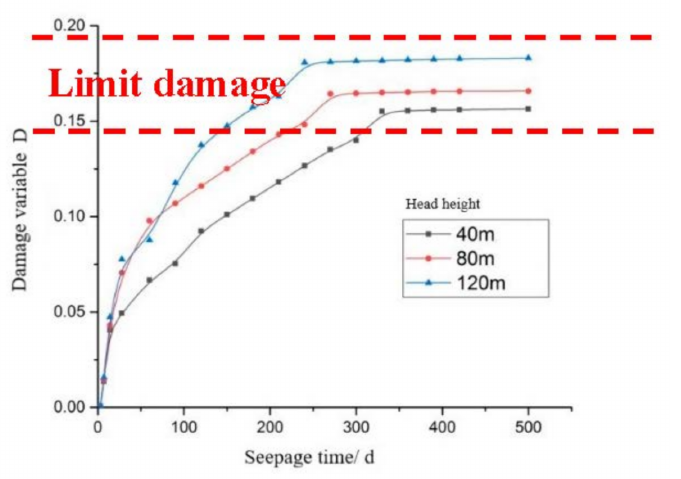
Figure 7. The damage variable changes of grouting-reinforced body with time under seepage